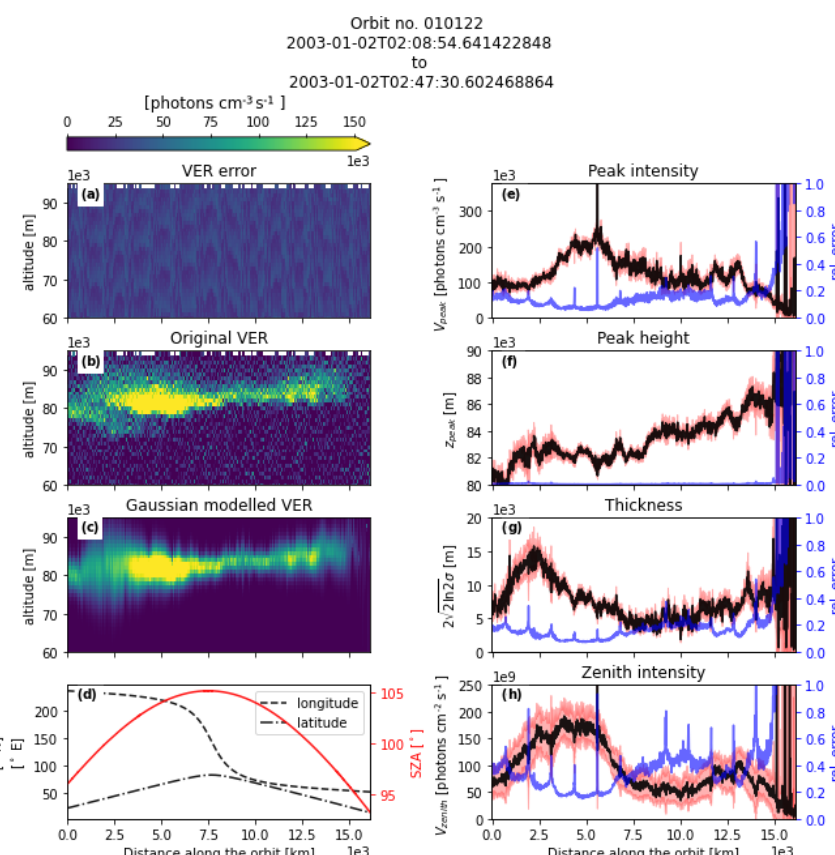
Figure 7. The data products resulting from orbit 10122: (a) the retrieved volume emission rate (VER) error, (b) the retrieved VER profiles, (c) the Gaussian reconstructed profiles, and (d) the longitude (black dashed line) and latitude (black dot-dashed line) coordinates of measure- ments along the orbit as well as the solar zenith angle (SZA; red solid line; right y axis). The modelled Gaussian OH airglow layer (e) peak √ 2ln2 σ and (h) zenith intensity V zenith are also shown. The black line corresponds to intensity V peak , (f) peak height z peak , (g) thickness 2 the expected value, the red shading corresponds to the expected value ± error and the blue line corresponds to the relative error (right y